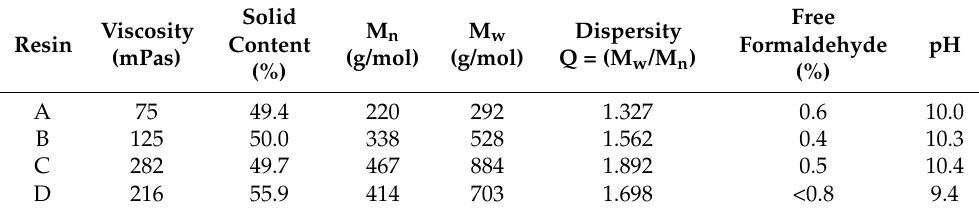
Table 1. Characteristic parameters of PF resins used in the